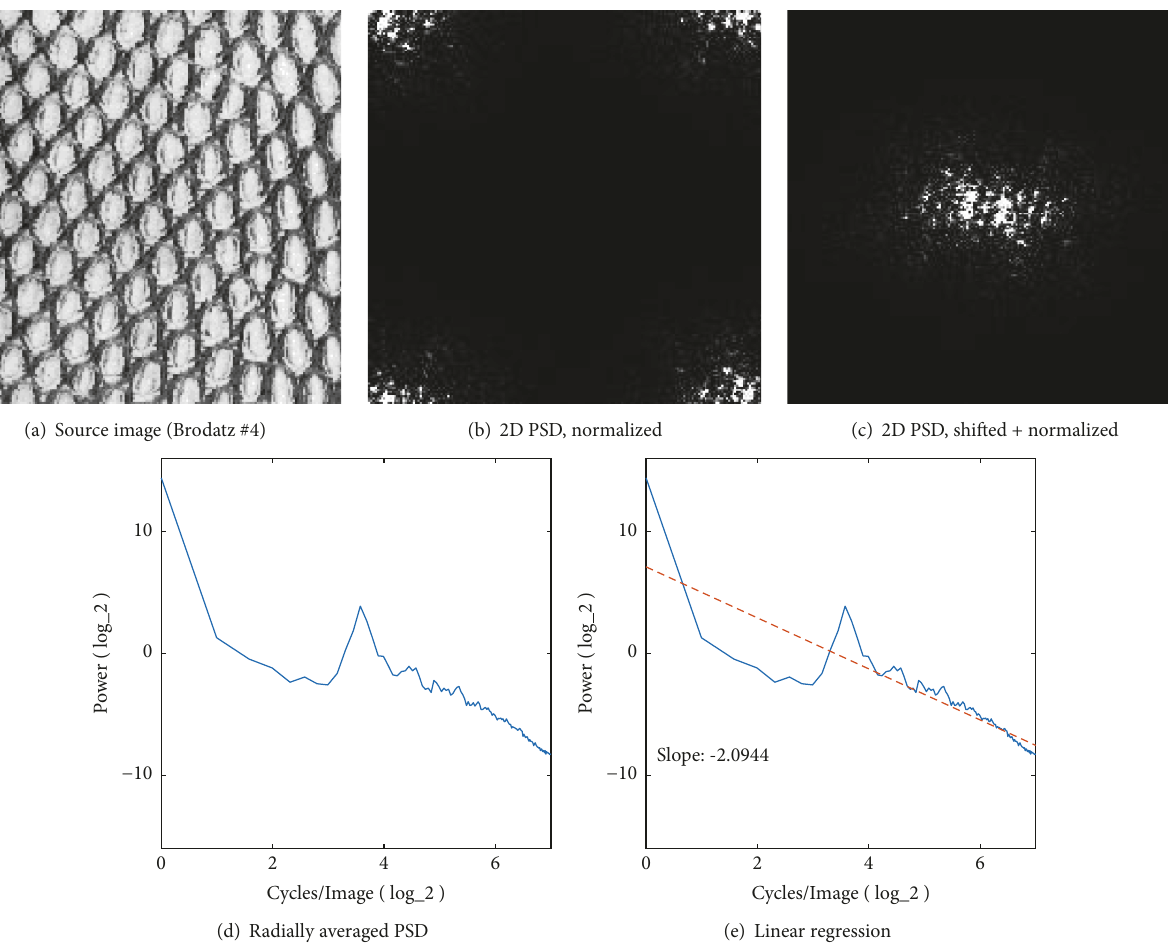
Figure 1: Power spectra pipeline.The source image in subfigure(a), undergoing 2D Fourier analysis, and its power spectral estimation shown in subfigure (b). As it provides for more interpretable charting and easier radial estimation, we “center” the coefficients by shifting them to diagonally opposite quadrants as seen in subfigure (c). We can then reduce dimensionality and produce useful aggregates by using radial averaging measures (d) and subsequent regressions